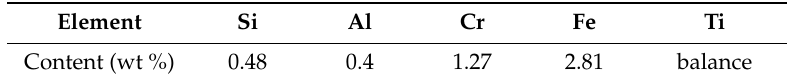
Table 1. Chemical composition of low alloyed Ti, analysed by energy-dispersive X-ray spectroscopy (EDS, Inca, Oxford, UK).